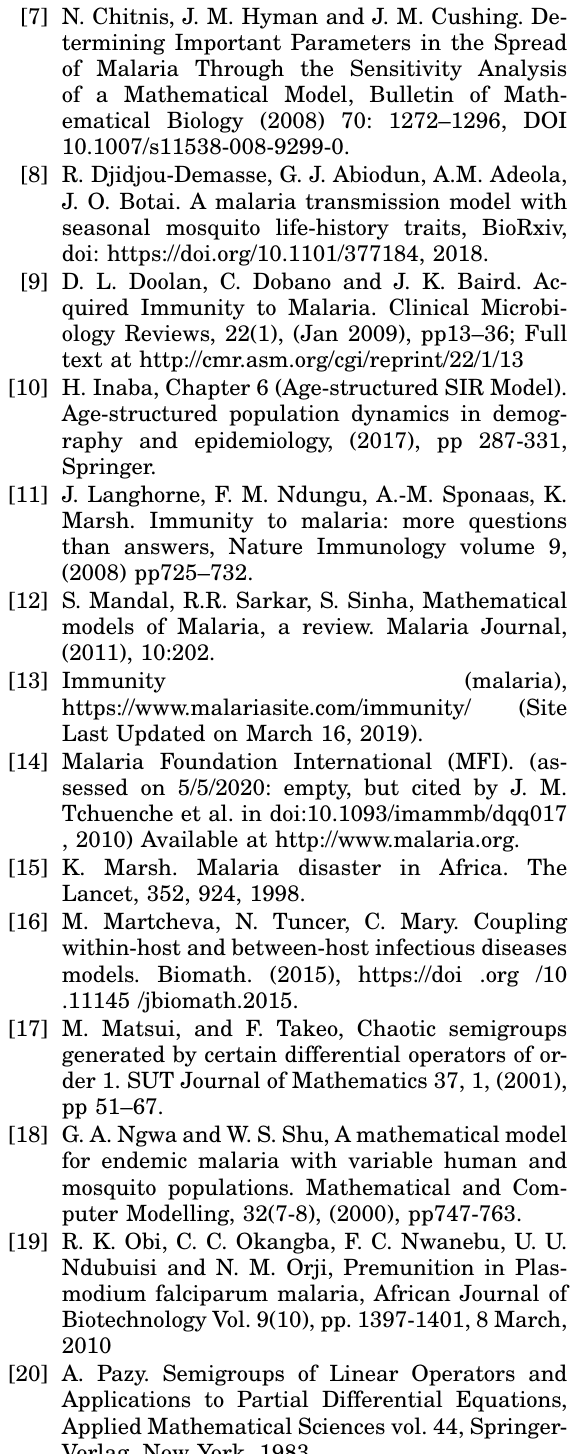
(cid:16) (cid:17) γ ( t , θ )) 1 − 1 10